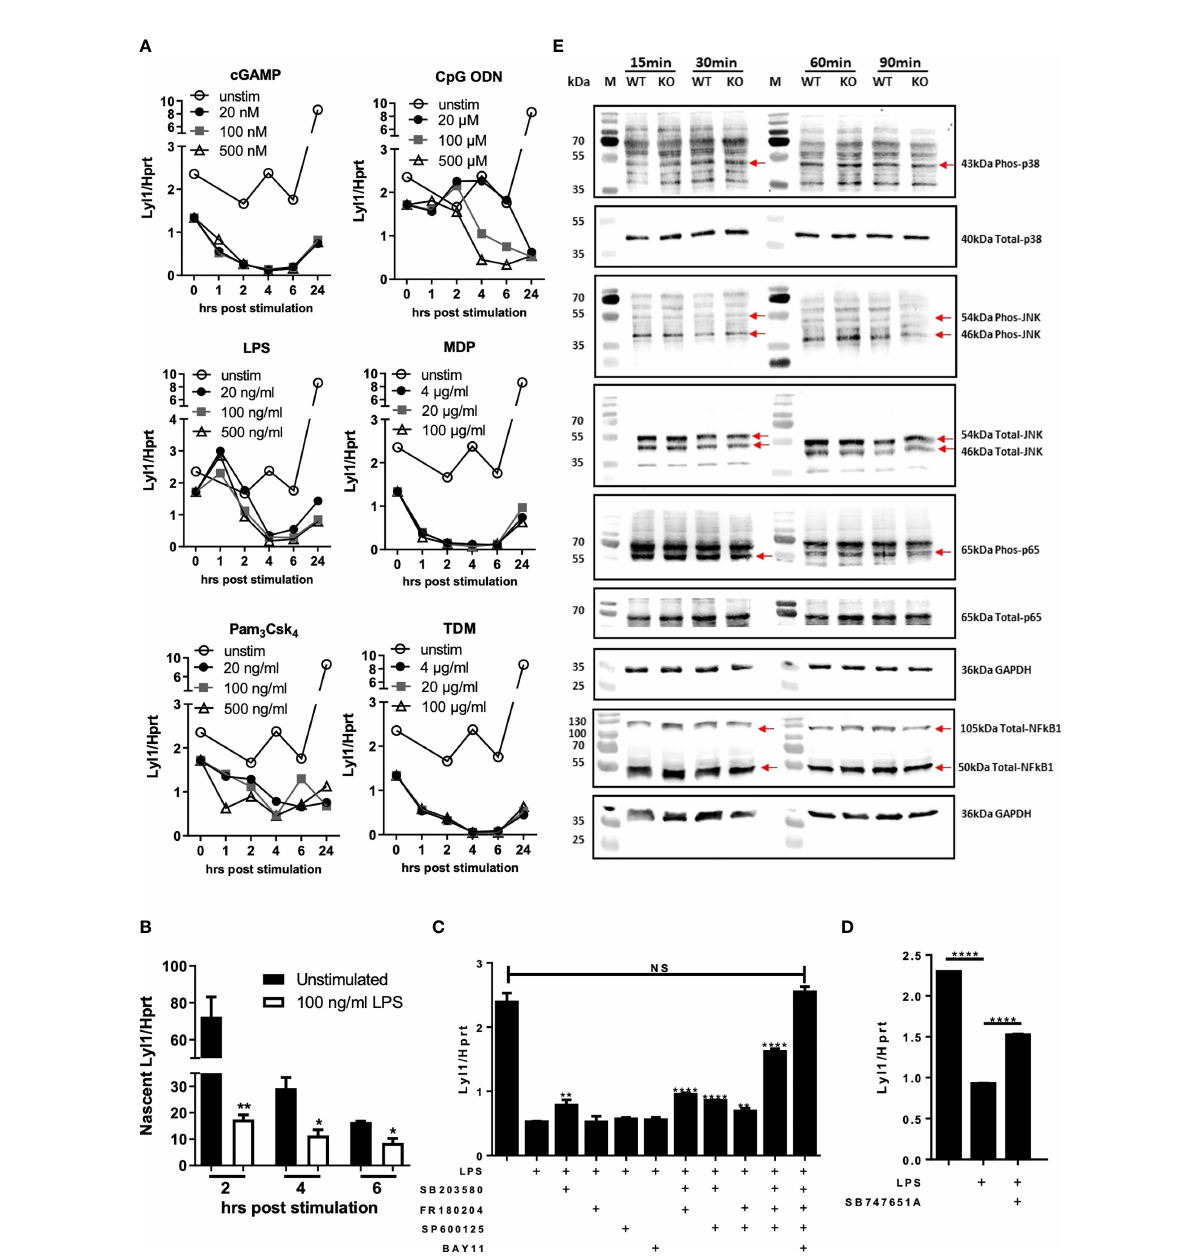
FIGURE 2 Lyl1 expression is downregulated by MAPk and NFkB signaling pathways in macrophages. (A) Various intracellular signaling pathways were activated in BMDM cells using cGAMP, CpG ODN, LPS, MDP, Pam3Csk4, or TDM at indicated concentrations. RNA was collected at 0, 1, 2, 4, 6, and 24 hrs hours and Lyl1 mRNA expression was investigated by RT-qPCR, relative to the Hprt housekeeping gene. (B) BMDM were stimulated with LPS (or unstimulated) and simultaneously tagged with biotinylated ethynyl uridine (EU) followed by RNA pulldown for nascent RNA collection. RT-qPCR was performed on synthesized cDNA to investigate Lyl1 mRNA expression. (C) BMDM were exposed to various inhibitor cocktails including 5 µM SB203580 (p38 MAPk inhibitor), 10 µM FR180204 (ERK1/2 MAPk inhibitor), 10 µM SP600125 (JNK MAPk inhibitor), and 7.5 µM BAY11 7084 (NFkB inhibitor) as well as (D) 10 µM SB747651A (MSK1/2 inhibitor) for 1 hour prior to 100 ng/ml LPS stimulation for 4 hrs. Cells were collected for RNA isolation and cDNA synthesis after which Lyl1 expression was investigated by RT-qPCR. Asterisks over the bars indicate statistical signi fi cance upon comparisons of inhibitor-treated samples versus LPS stimulated sample. (E) WT and Lyl1 -/- BMDM were stimulated with 100 ng/ml LPS, and protein lysates were collected at indicated time points after which western blot analysis on 30µg loaded protein was performed using phospho-p38 MAPk, total-p38 MAPk, phospho-SAPK/JNK MAPk, total-SAPK/JNK MAPk, phospho-RelA (p65), total-RelA (p65), total-NF k B1 (p50/p105), as well as GAPDH primary antibodies. Data shown are representative of two independent experiments. Unpaired student t-test analysis at * p < 0.05, ** p < 0.01, **** p < 0.0001 to determine signi fi cance, ns, not signi fi